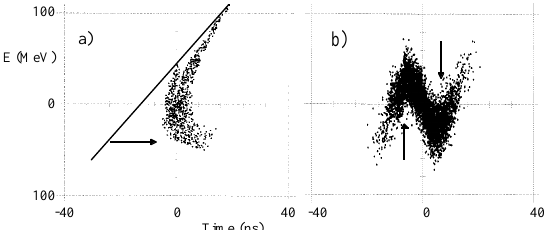
FIG. 2. Effects of nonlinear h and space charge on the final phase space distributions. (a) Shows the effect of a quadratic horizontal shear which occurs when a (cid:49) (cid:222) 2 (cid:49)(cid:46)(cid:53) , and (b) shows the effect of vertical shear from strong space charge